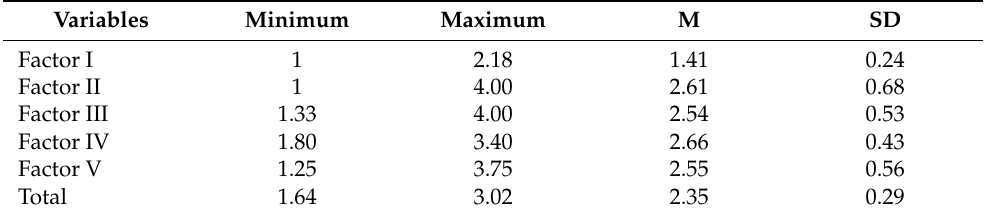
Table 2. Minimum, Maximum, Mean and Standard Deviation of students’ perceptions of attention to diversity ( N =